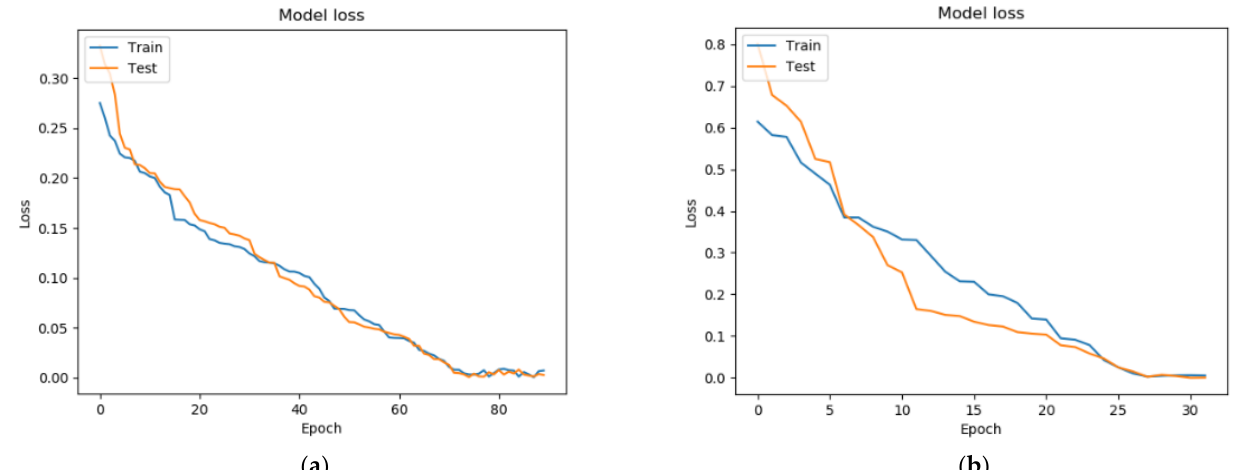
Figure 5. Graphs of the loss function for training a neural network according to the data of the testing modules. ( a ) shows a graph for a neural network developed using a genetic algorithm, while ( b ) shows a graph of a neural network designed using an analytical method.